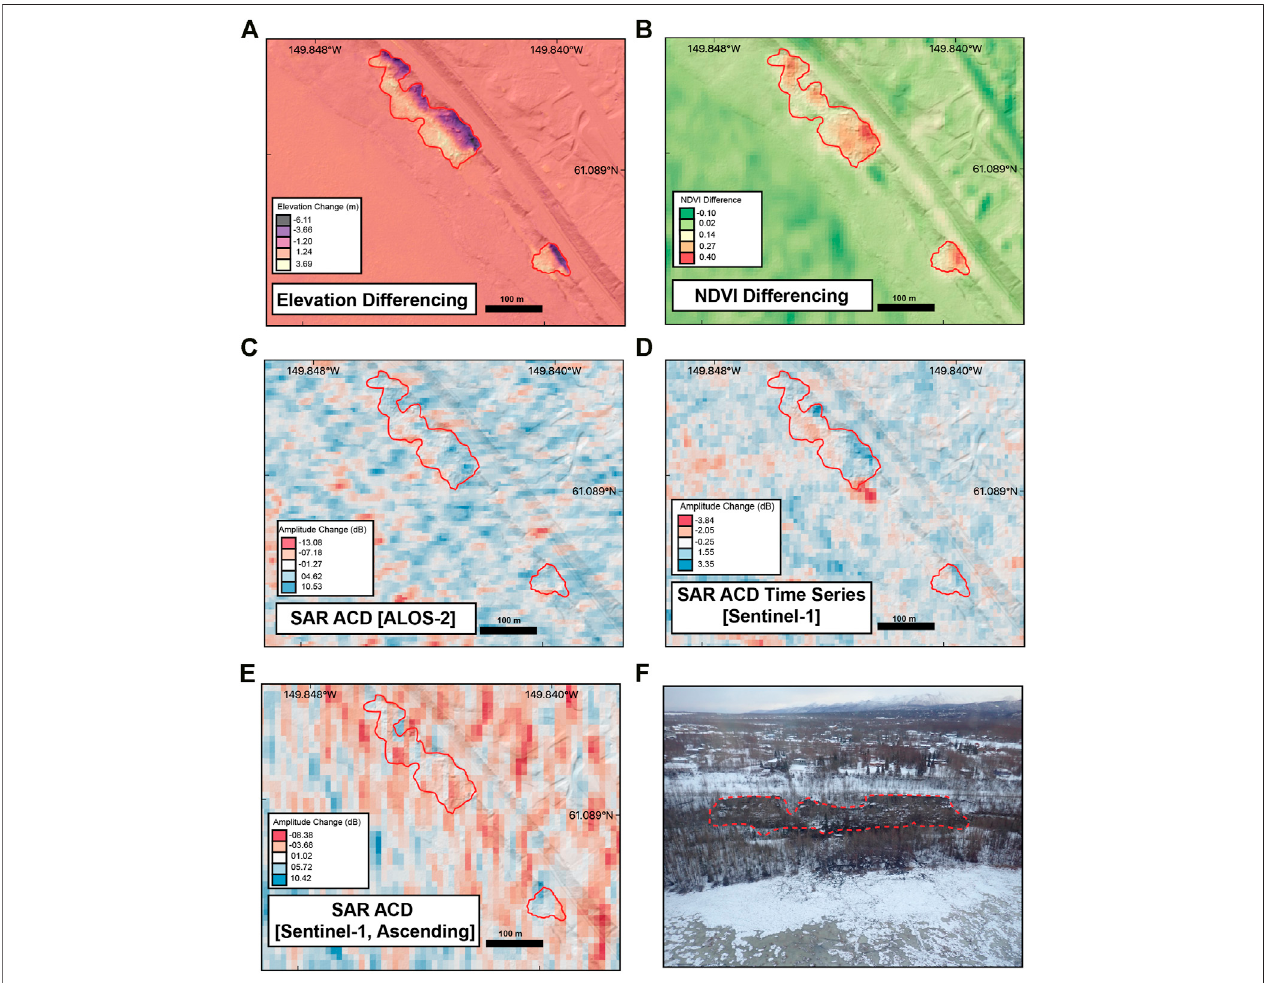
FIGURE3| Anexampleoftheperformanceofeachmethodatdetectingrapidsoil fl ows(outlinedinred).Panel (A) showstheperformanceofelevationdifferencing and (B) shows the performance of NDVI differencing. Panels C – E display the performance of the remaining SAR ACD methods. An aerial photo of these rapid soil fl ows can be seen in panel (F) (Photo Credit: